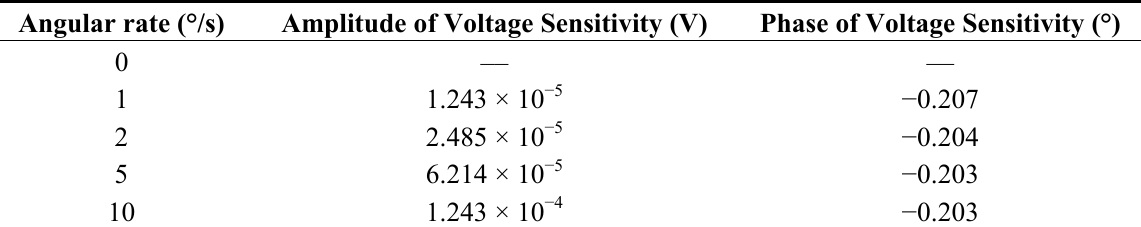
Table 2. Simulation data with different angular rates.